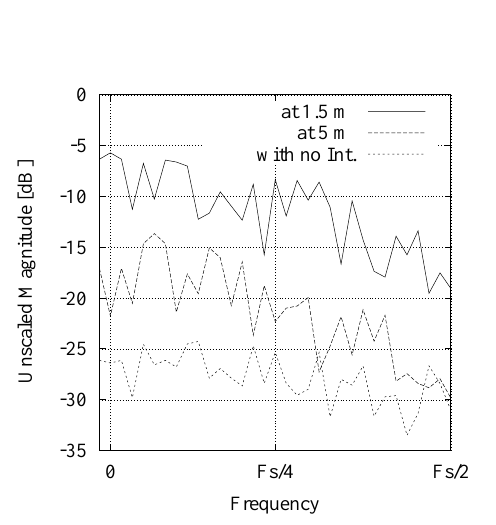
Figure 10. Averaged FFTs for different distances between receiver and